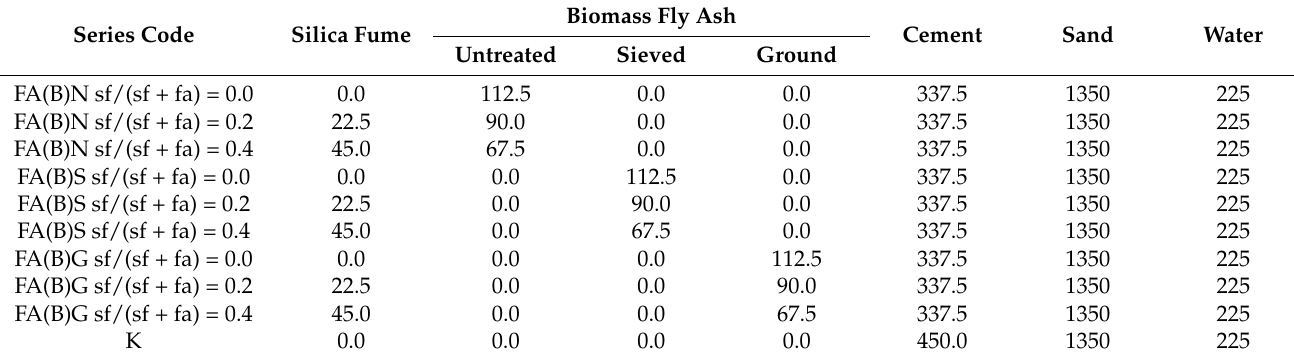
Table 5. Cement Mortar Mix Proportions